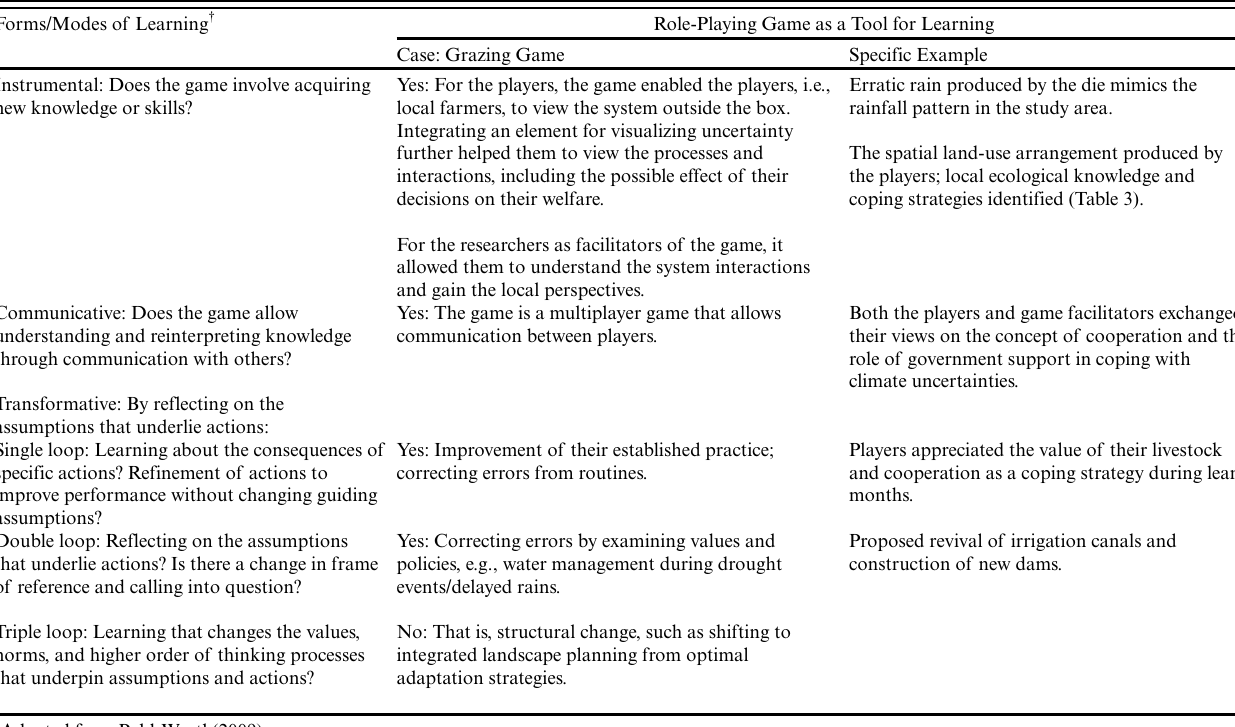
Table 5 . Assessment of grazing game as a social-learning